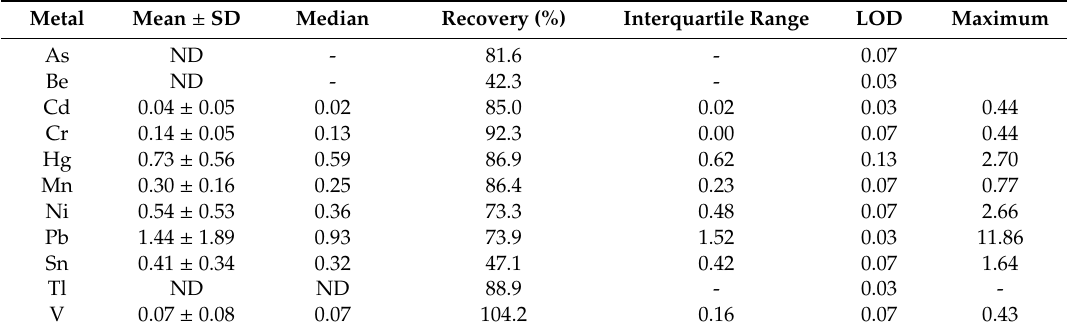
Table 1. Metal concentrations ( µ g / g) in hair of 94 school children living in Tarragona County (2017).